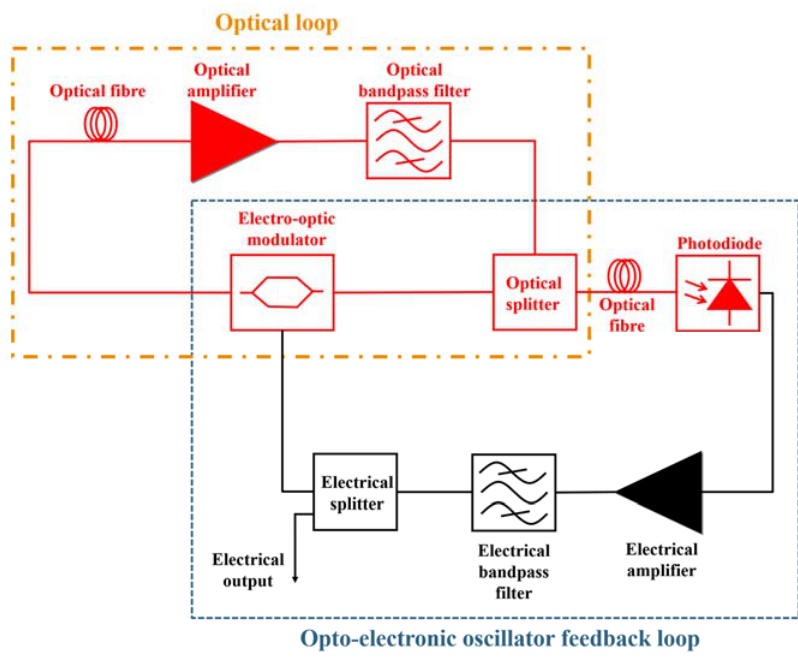
Figure 5. Typical configuration of a coupled OEO.